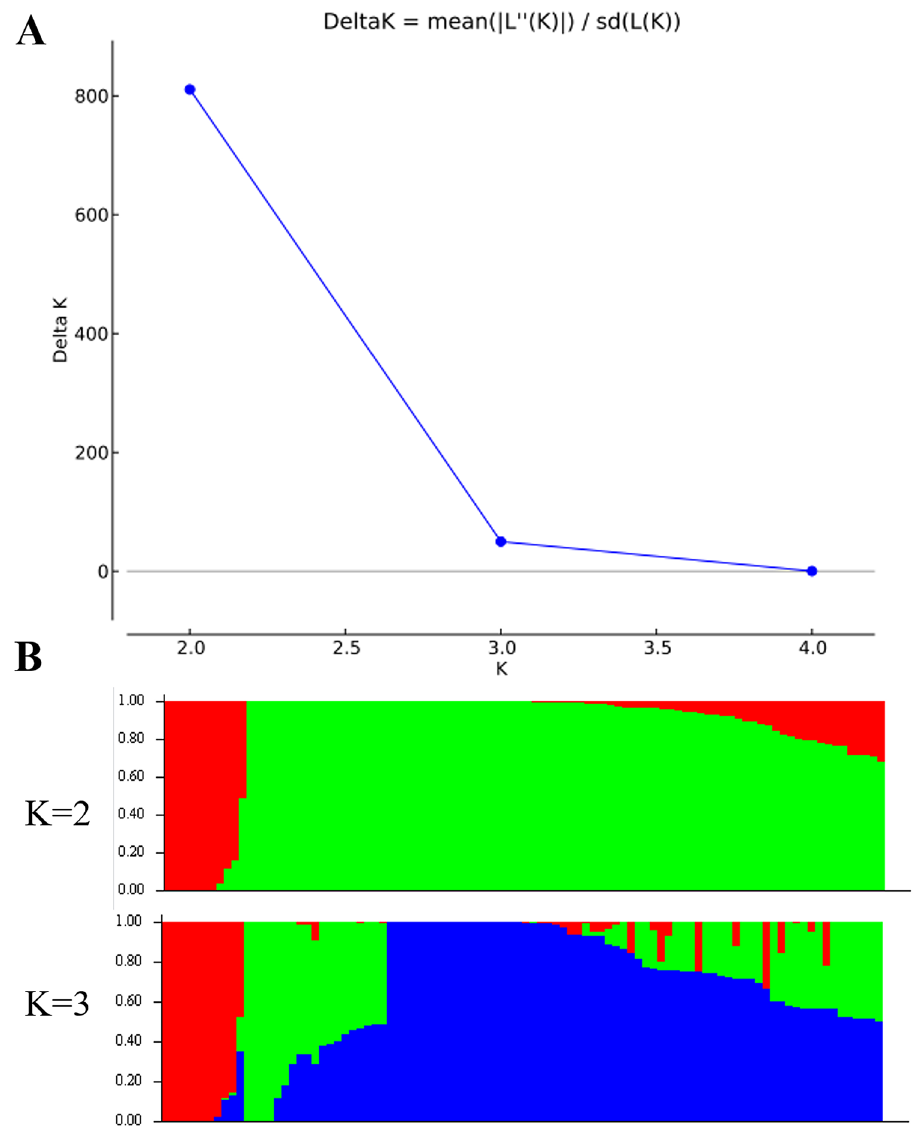
Figure 2. Population structure analyses of 96 peanut genotypes in the Korean set based on high-resolution SNPs assessed by STRU CTU RE (http:// pritch. bsd. uchic ago. edu/ struc ture. html). ( A ) Determining delta K values for different numbers of populations ( K = 2) or 3 clusters ( K = 3). ( B ) Bar plot for the K value = 2 or 3. The population structure analysis was performed with admixture 1.3 43 . Color segments represent different groups inferred by STRU CTU RE